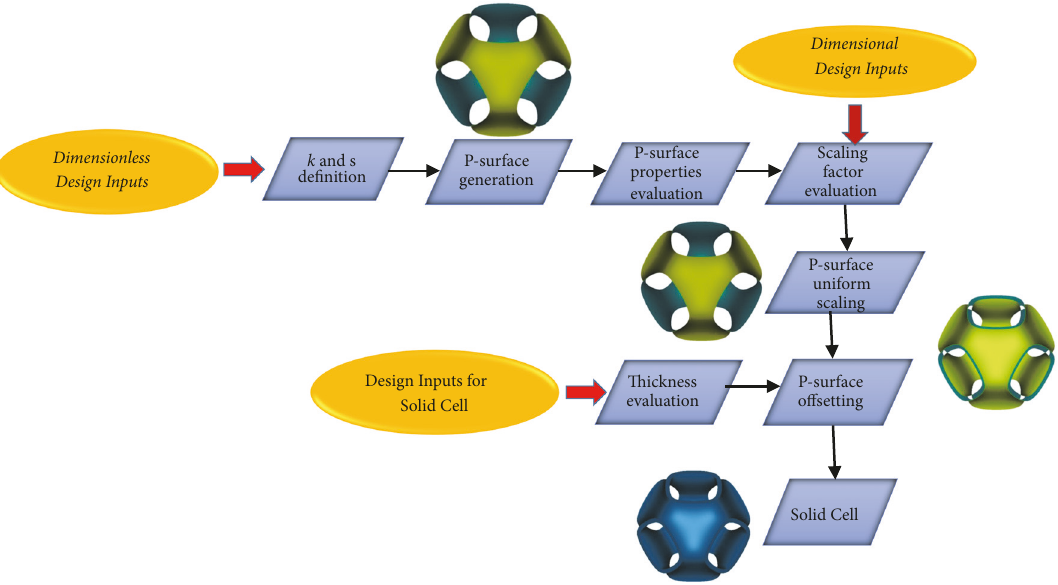
Figure 13: Flowchart of the design process of a solid